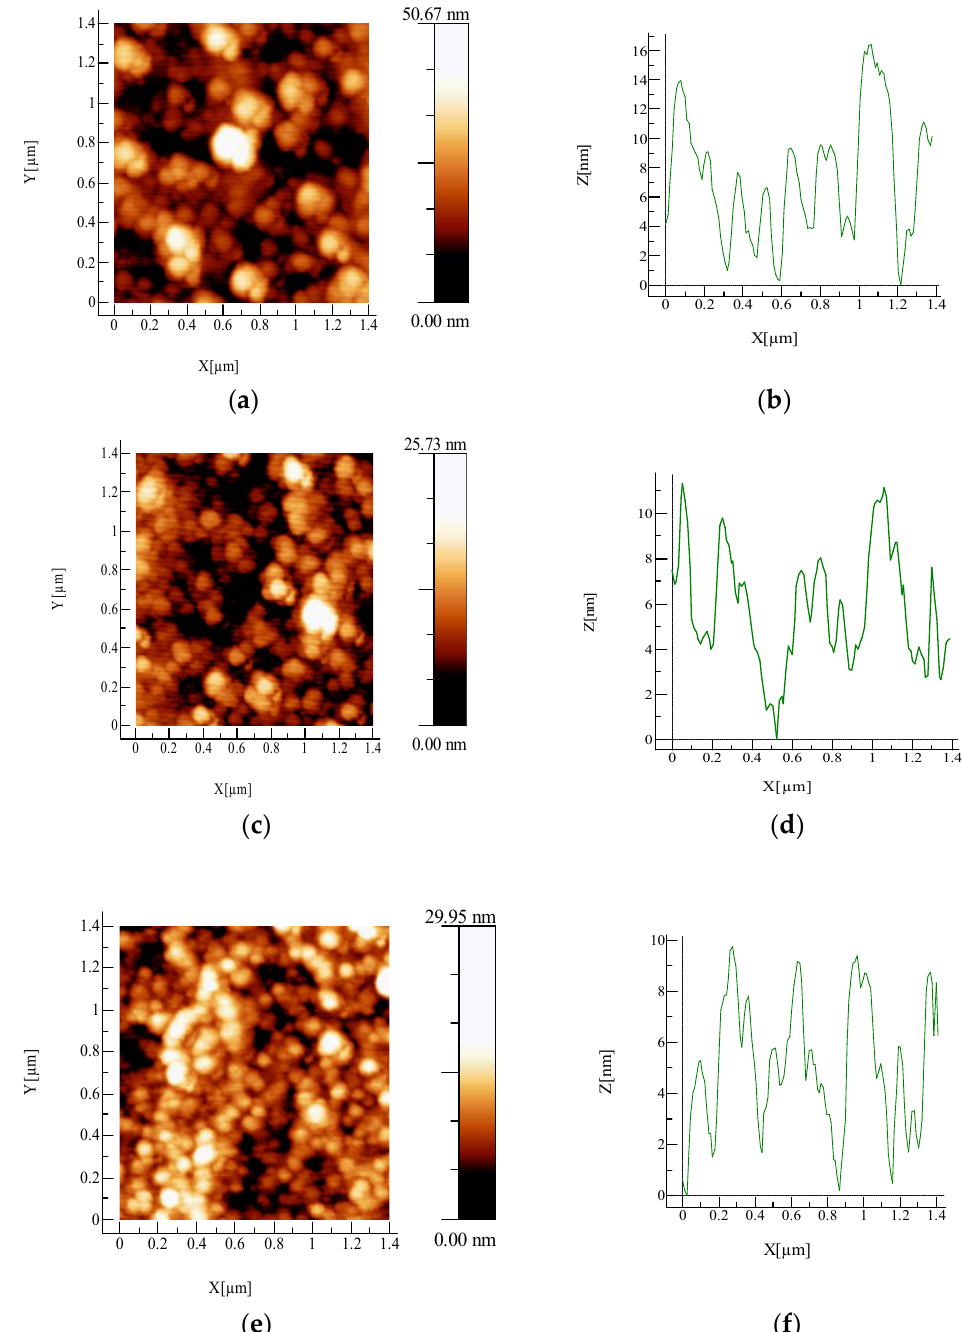
Figure 3. AFM images ( a ): Pure NiO, ( c ) 6% Cu-NiO, ( e ) 10% Cu-NiO; ( b ), ( d ), ( f ): profile showing the evolution of pure NiO, 6%, and 10% Cu-NiO film surfaces.